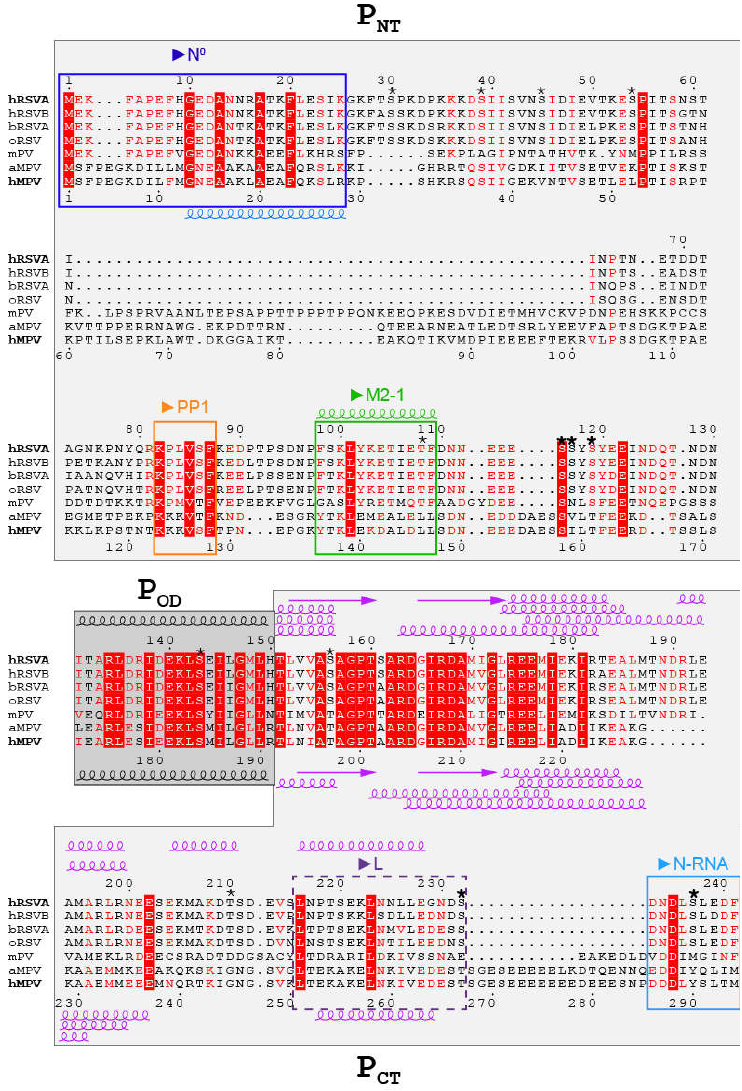
Figure 2. Sequence alignment of the Pneumoviridae phosphoproteins for the two genera Orthopneu- movirus : human RSV strains A and B (hRSVA/hRSVB, Uniprot record numbers P03421/O42062), bovine RSV (bRSV, P33454), ovine RSV (oRSV, Q83956) and murine pneumonia virus (mPV, Q5MKM7); and Metapneumovirus : avian MPV (aMPV, Q2Y2M5) and human MPV (hMPV, Q8B9Q8). Sequence numbers are indicated for hRSVA on top and for hMPV at the bottom. Color- ing was made according to sequence conservation with ESPript 3 [35]. Constitutively phosphory- lated hRSV P serines are marked with bold stars. Other phosphorylatable Ser/Thr sites are marked with regular stars. Secondary structures, drawn for hRSVA and hMPV P, were taken from the X- ray crystal structures of hMPV P OD (PDB 5oix), hMPV N 0 –P (PDB 5fvd) and hRSV M2-1–P (PDB 6g0y) and cryo-EM structures of hRSV L–P (PDB 6pzk) and hMPV L–P (PDB 6u5o) complexes. P CT protomers adopt different conformations in the L–P complex. The interaction regions are boxed, and the protein partners indicated on top. For L, only the partial binding region reported in [36] is shown.